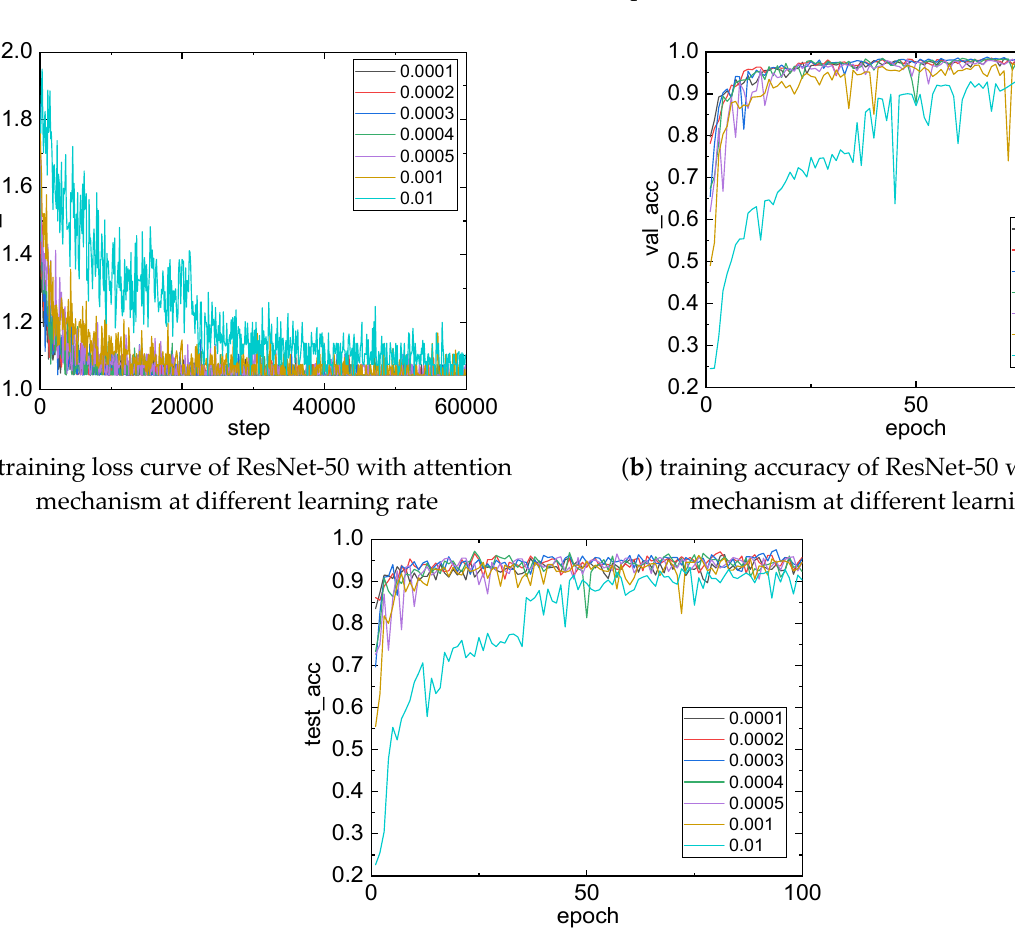
( c ) test accuracy of ResNet-50 with attention mechanism at different learning rate Figure 6. Results of ResNet-50 with attention mechanism at different learning rates.